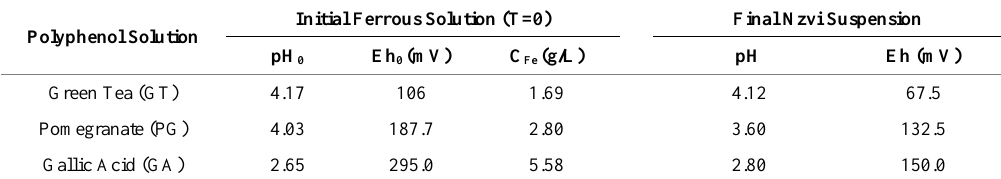
Table 2. Physicochemical properties of initial solution and final nZVI suspension. Polyphenol Solution